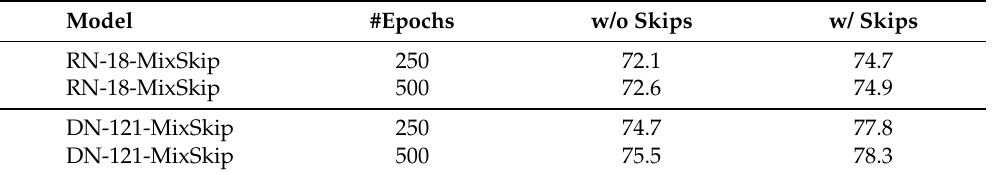
Table 3. Influence of number of training epochs on different models trained with the MixSkip procedure. Models are evaluated with and without skip connections on Cityscapes